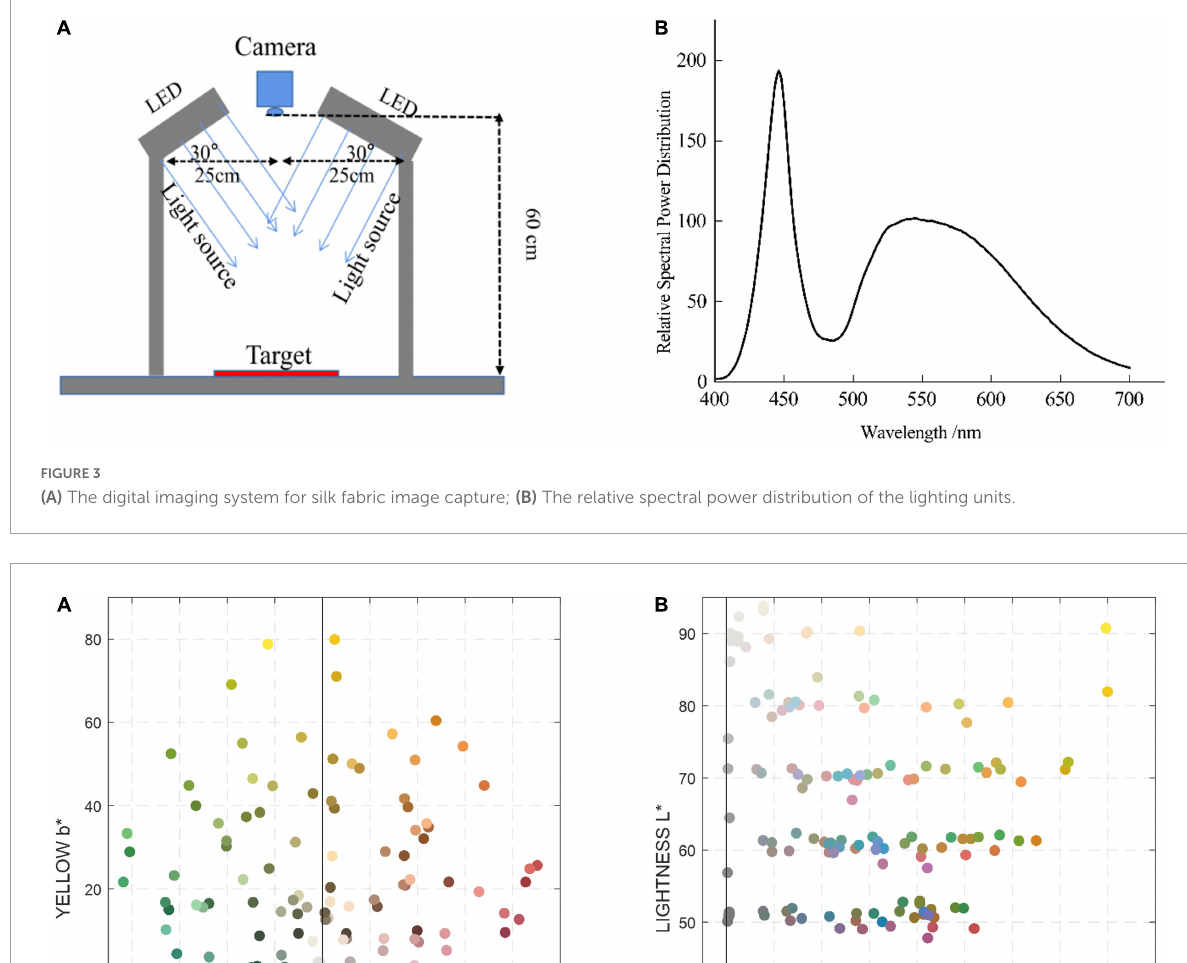
Palette” color chart) and three mapping methods (1st PR, 2nd PR, 3rd PR). The results of all models were listed in Table 1 including the mean, minimum, and maximum CIELAB color difference across all testing color samples. The distribution of the color difference across all testing samples in different camera color characterization models shows in the box plots in Figure 6